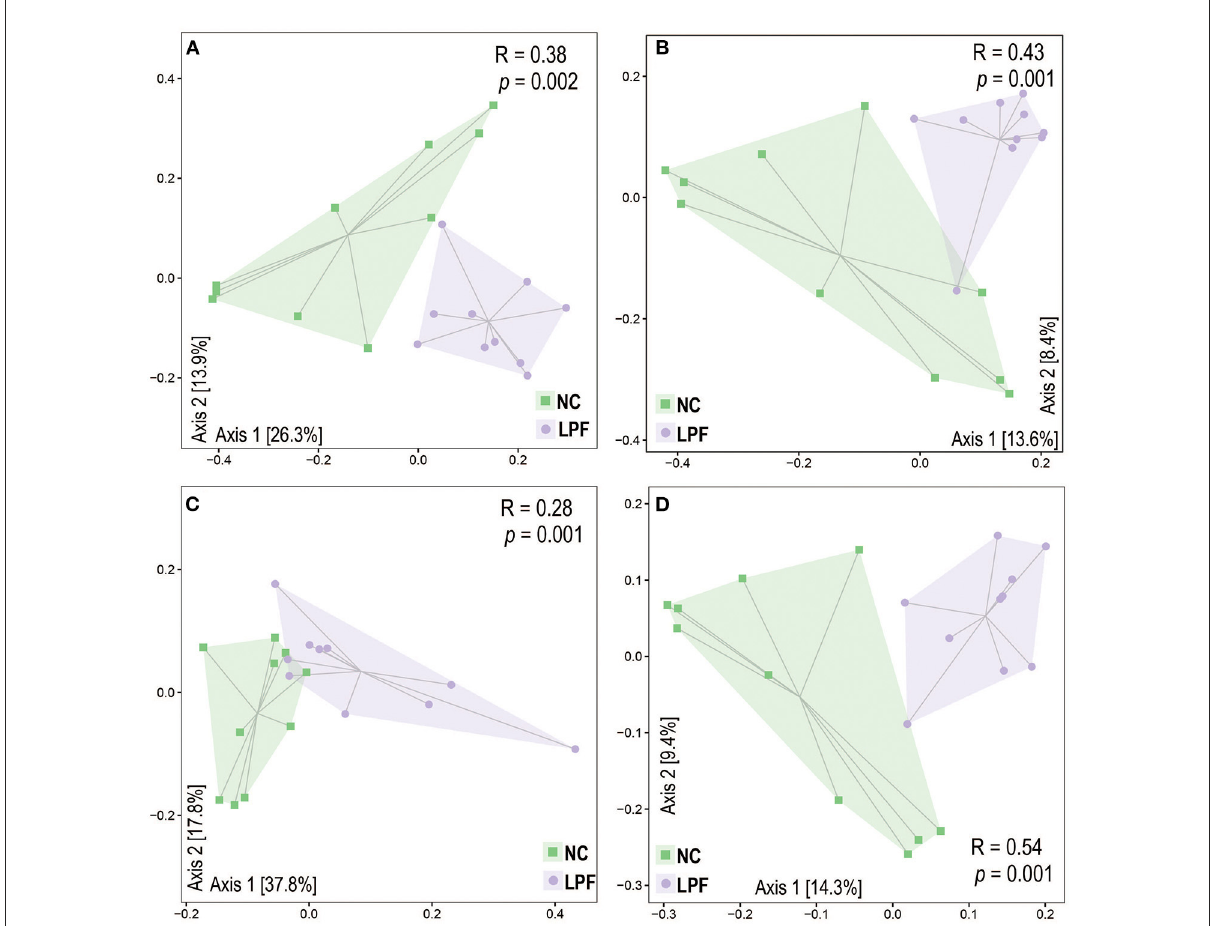
FIGURE2 LPF diet modulated gut microbiota beta diversity based on (A) Bray-Curtis, (B) Jaccard, (C) Weighted UniFrac, and (D) Unweighted UniFrac distances. The analysis of similarity (ANOSIM) was applied to estimate the dissimilarity between NC and LPF treatments. NC diet: basal diet,